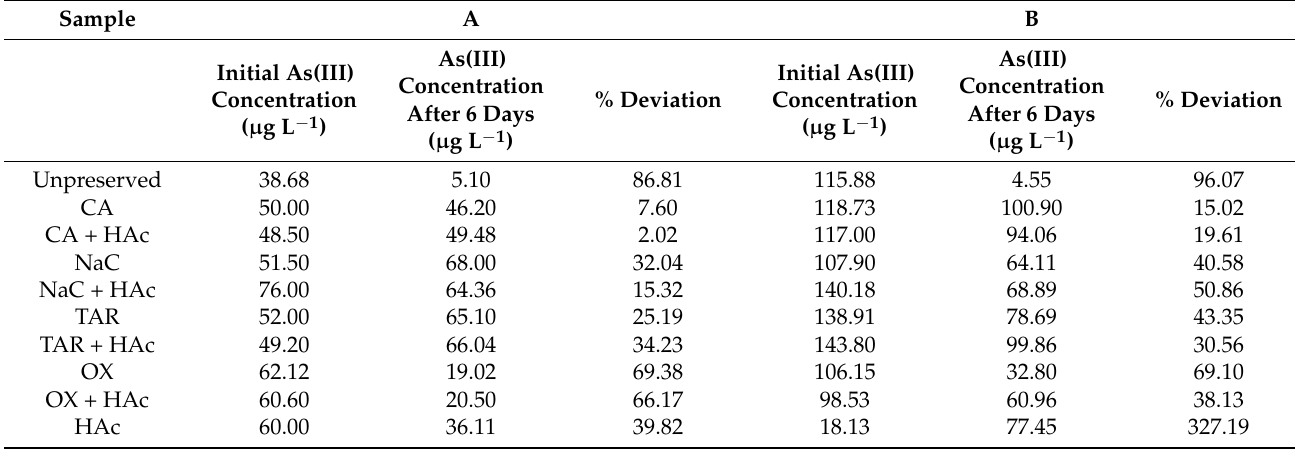
Table 3. Summary of the results for arsenic preservation using nine preservatives in natural groundwater samples A and B, in the presence of iron.